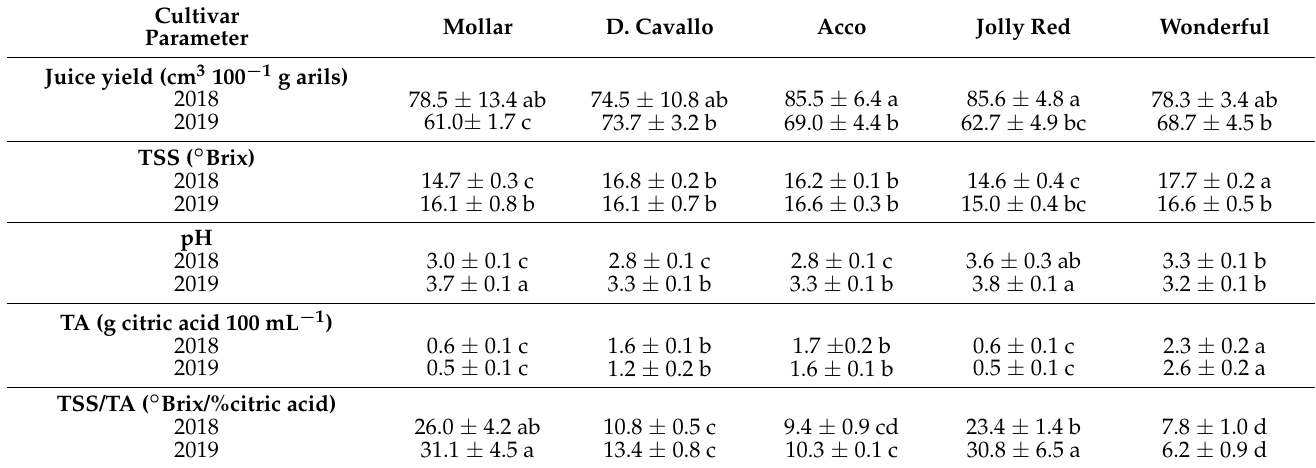
Table 5. Juice characteristics from different pomegranate cultivars in 2018 and 2019